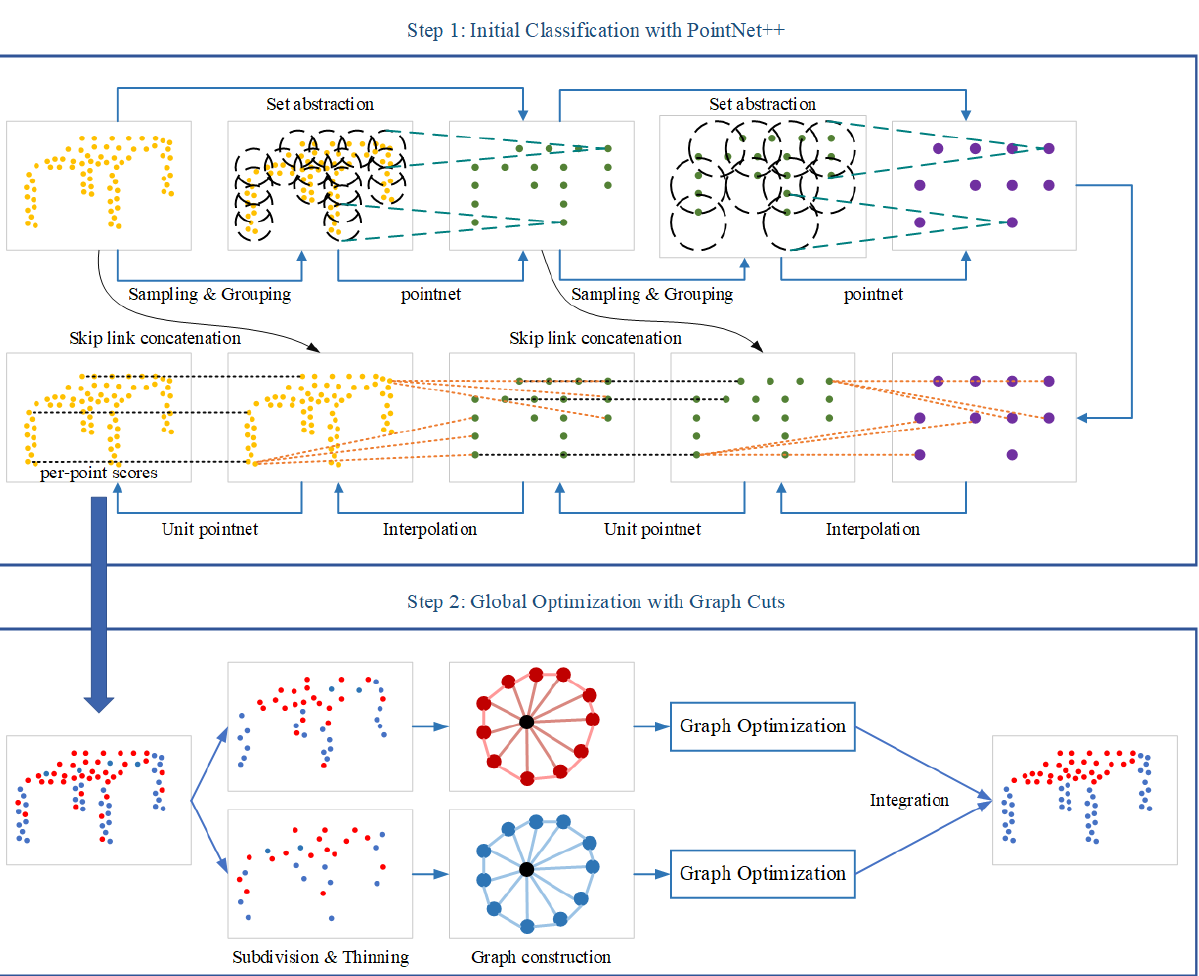
Figure 2. Overview of the proposed classification